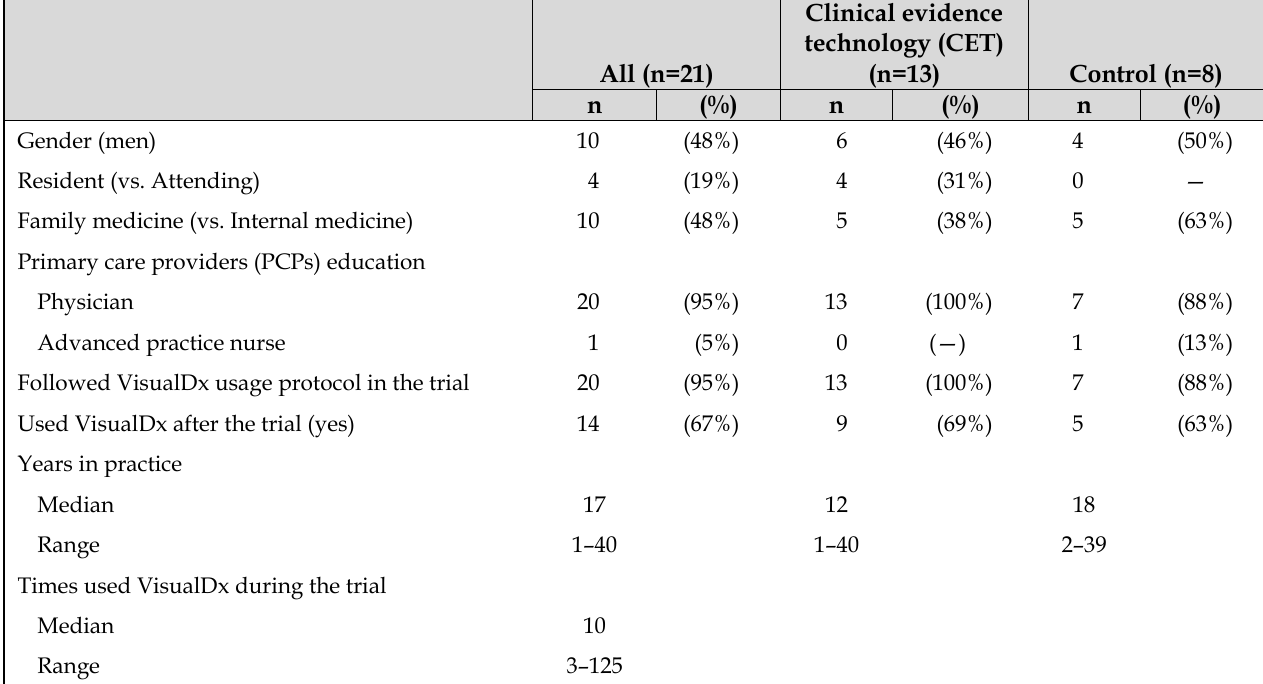
Table 1 Characteristics of primary care providers (PCPs) and clinical evidence technology (CET) usage in post-trial survey